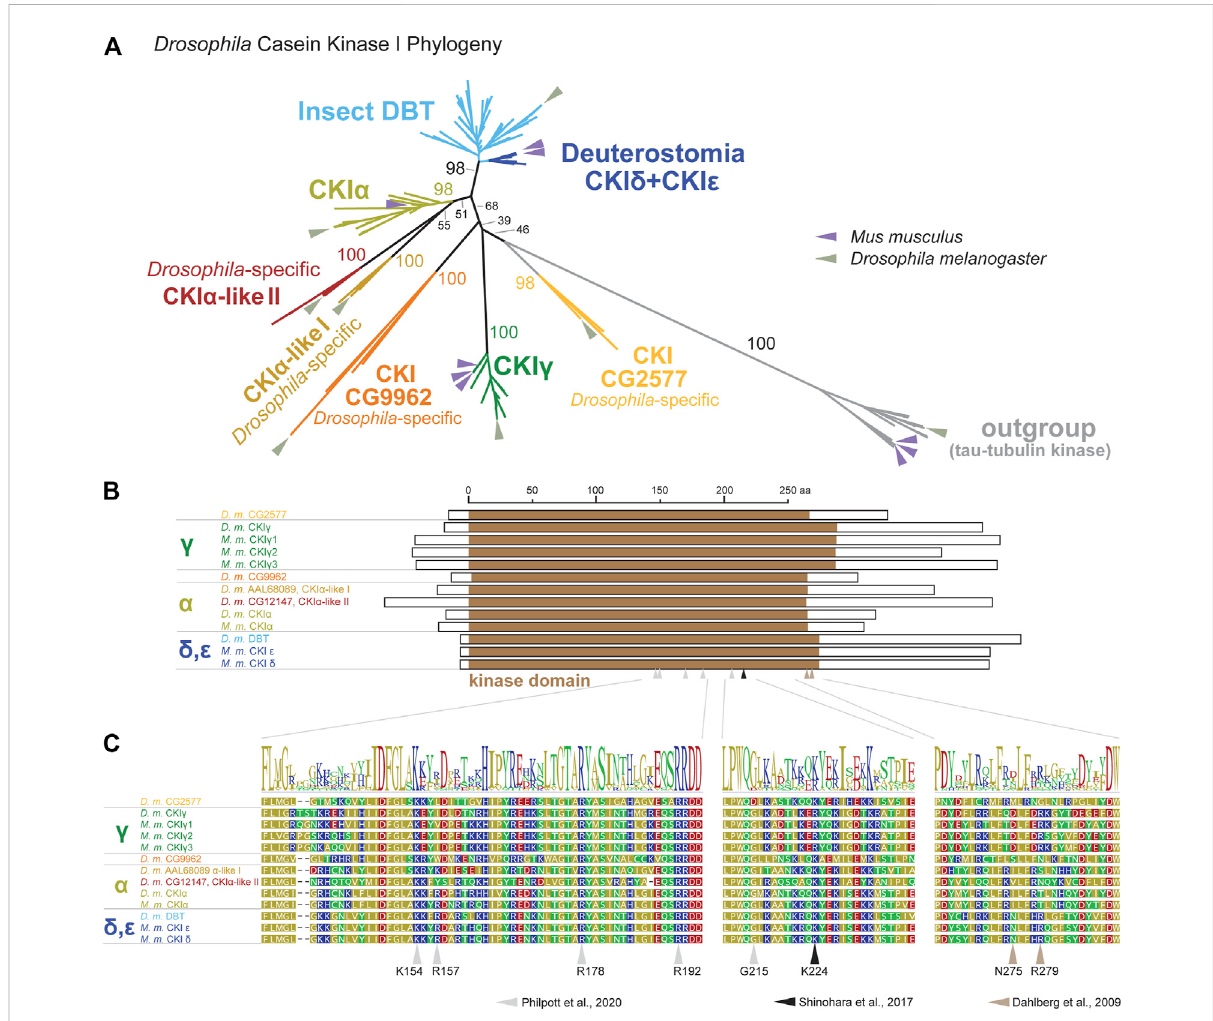
Phylogeny of bilaterian Casein kinase I (CKI) reveals seven clearly separated CKI-coding genes in fruit fl ies ( Drosophila genus). (A) A tree illustrating relatedness among CKI proteins (values above branches indicate bootstrap support), in which well-separated clusters are color-coded. Insect DBTs (cerulean) branch together with deuterostomian sequences (cobalt blue) including CKI ε and CKI δ from fi sh, amphibia, reptiles, and mammals. Besides well-established isoforms CKI α and CKI γ (the latter encoded by gilgamesh in Drosophila ), four Drosophila genus-speci fi c clusters were detected. Two of them branch at the base of CKI α and are therefore labeled as CKI α -like I (peanut) and CKI α -like II (cinnamon brown). Two additional clusters are separated from established CKI isoforms and are labeled according to the D. melanogaster nomenclature as CG9962 (orange) and CG2577 (apricot). Tau-tubulin kinases (a.k.a. asator in D. melanogaster ) serve as an outgroup. Positions of the fruit fl y D. melanogaster and the mouse Mus musculus proteins are highlighted by arrows in sage green and lavender, respectively. In established CKI terminology, the term isoform ( α , γ , δ , ε )is used to refer to kinases encoded by distinct genes, although some of these genes might also encode different splice variants (for clarity, we use the term “ splicing isoforms ” ). Multiple arrows in the mouse refer to gene multiplications, not to splicing isoforms. The phylogenetic analysis strongly supports the existence of the new groups of CKI genes in Drosophila and con fi rms already established groups. However, the relationship among CKI groups is sometimes poorly supported and the tree should not be interpreted as a focused analysis of CKI history. The tree wasinferredusingRAxMLmaximumlikelihoodof239proteinsequences( fi nalGAMMA-basedscoreofthebesttree-72993.763796)usingGeneious 11 software (Biometters). Bootstrap support was calculated from 100 replications. See Supplementary Tables S1, S2 for accession numbers of analyzed sequences. (B) Schematic illustration of CKI proteins with highlighted kinase domain (brown), N- and C-terminal tails are shown as empty rectangles. (C) Detailsofproteinalignmentwithhighlighted residues thatareimportantfor thefunction ofCKI δ (Shinohara etal.,2017;Philpottetal., 2020) and DBT (Dahlberg et al.,